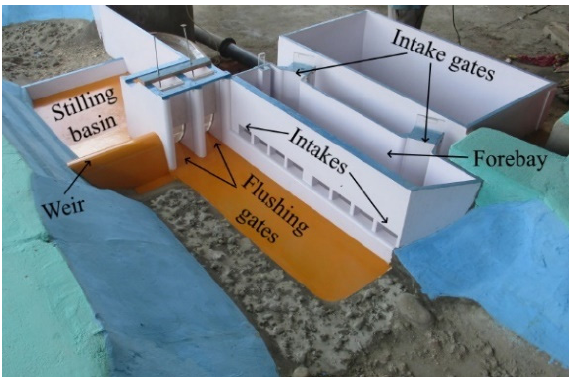
Figure 5. Khimti River model with location of 8 GCPs (R1-R3 in the right bank and L1-L5 in the left bank). The figure shows the fixed bed river model which is then filled with mobile sediment bed.